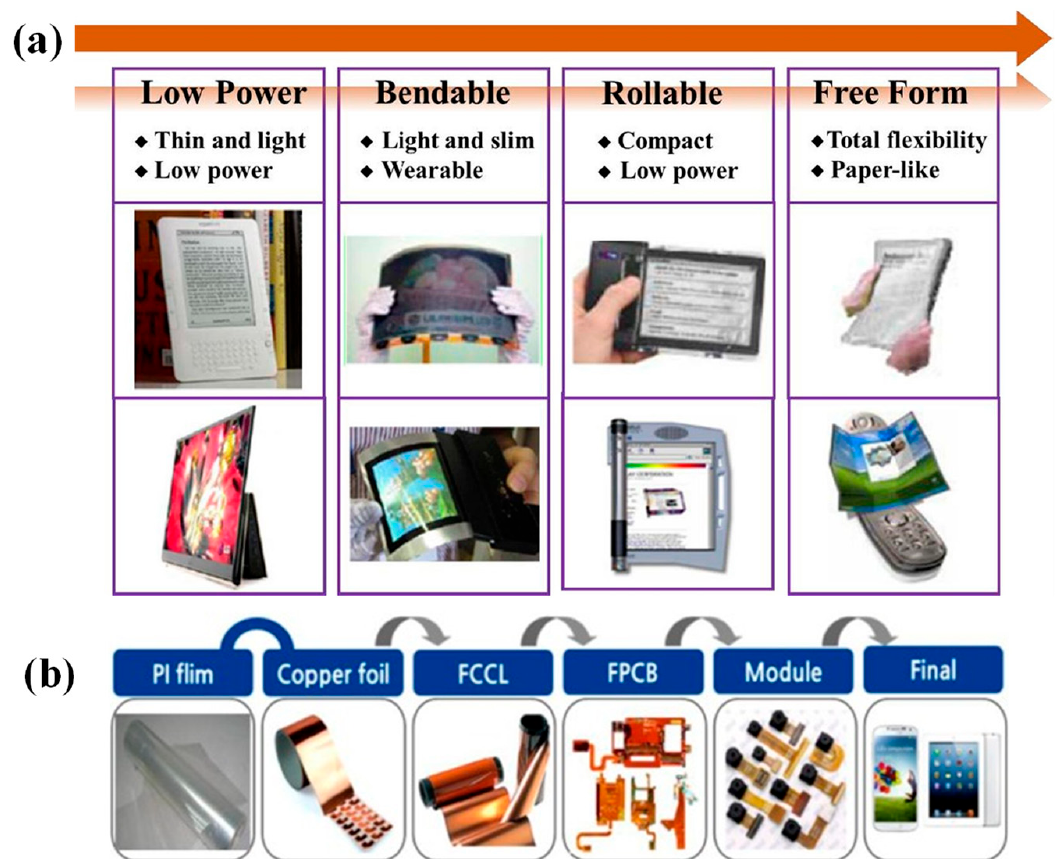
Figure 15. ( a ) Roadmap for flexible products and substrates. ( b ) Flexible printing circuit boards’ (FPCB) industry chains from flexible copper clad laminate (FCCL) to final products. Reprinted with permission from Ref. [151]. 2020, Elsevier.